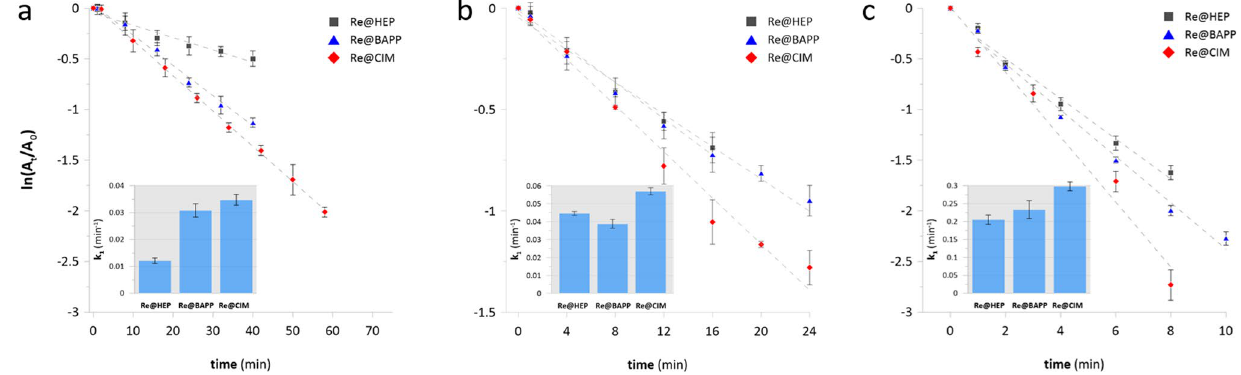
Figure 6. 4-NP reduction first-order kinetics plots. The graphs represent processes using Re@HEP, Re@BAPP and Re@CIM NCats: ( a ) 5 mg, ( b ) 10 mg, ( c ) 50 mg.